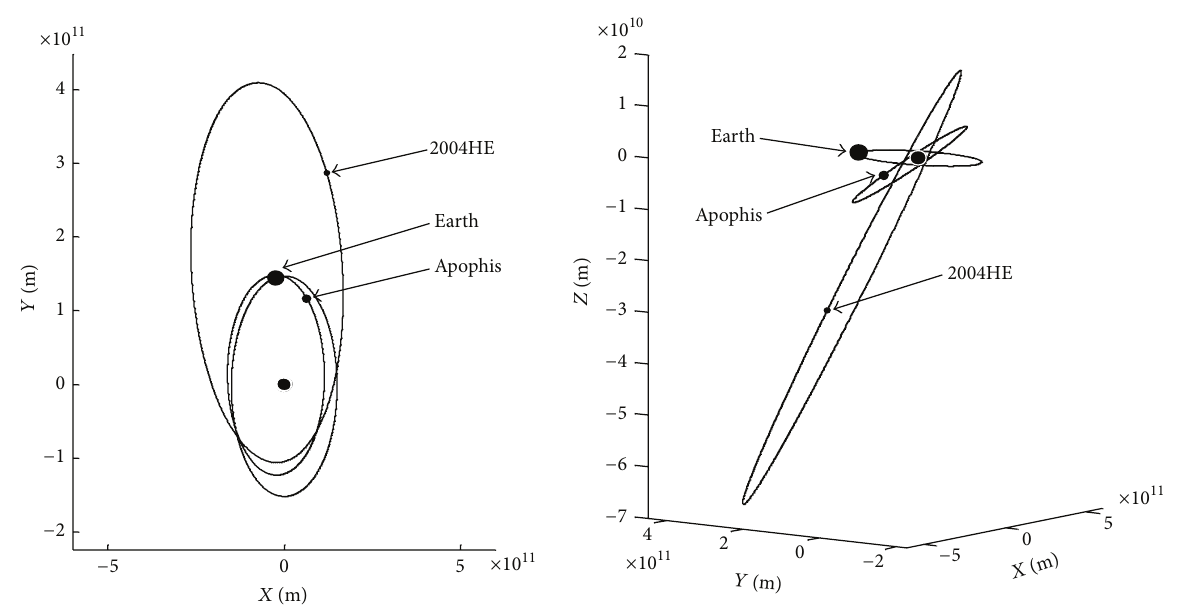
Figure 1: Orbits and positions of Earth, Apophis, and 2004HE.